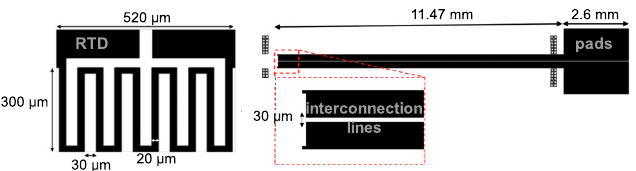
Figure 2. Design and geometrical dimensions of RTD patterned on the